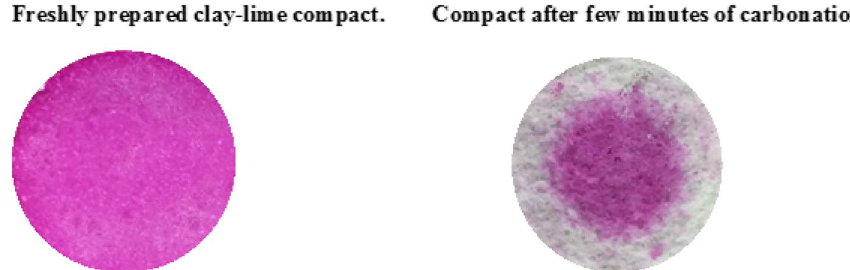
Fig. 5 Carbonation progressing from compact surface towards